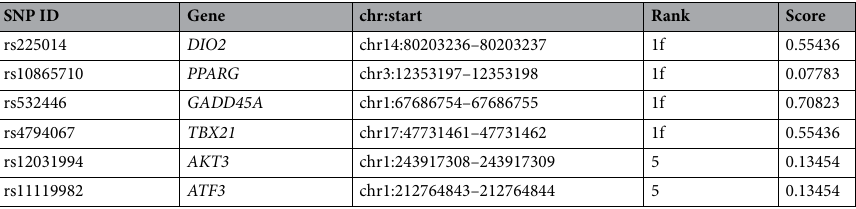
Table 7. RegulomeDB results for SNPs within selected regions. 1f—eQTL + TF binding/DNase peak; 5—TF binding/DNase peak; The RegulomeDB probability score ranges from 0 to 1 and the higher it is the more likely to be a regulatory